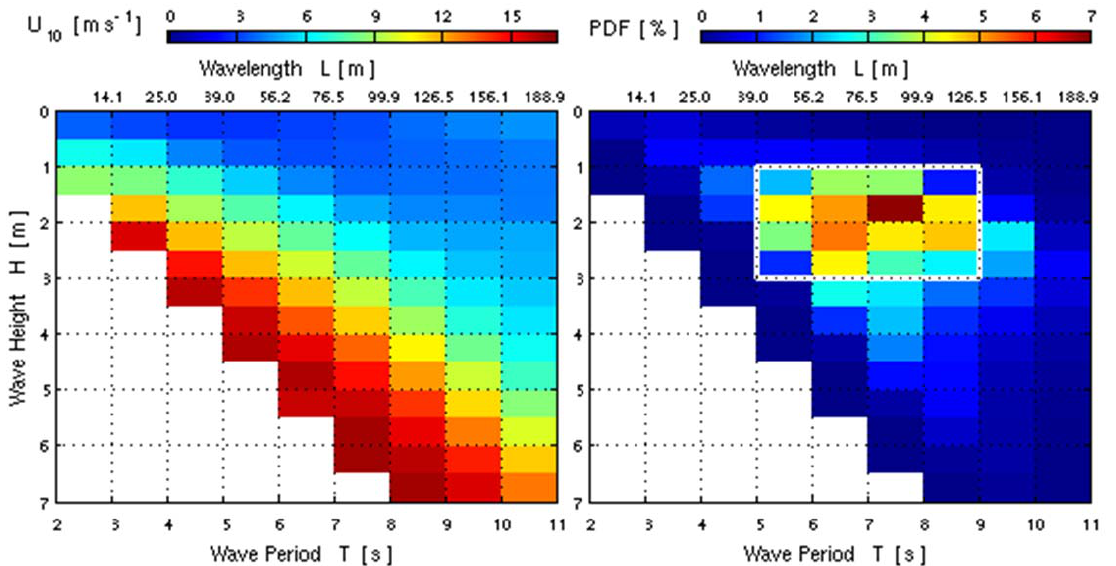
Fig. 2 : Sea states under consideration for underwater light field simulations with dx =10cm horizontal resolution; left: input parameters (wave height H , wave period T , and wind speed U 10 ) for the generation of irregular wave profiles; right: probability of the occurrence of wave classes averaged over all seasons and regions (Sterl and Caires, 2005).